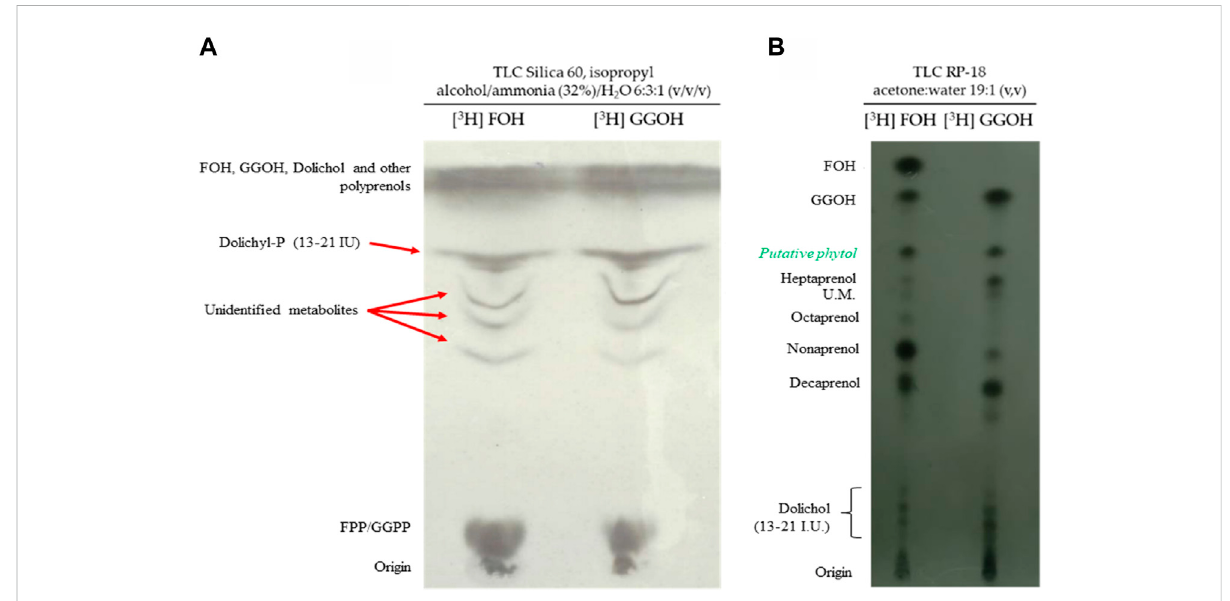
FIGURE 3 The metabolization of isoprenoid alcohols. (A) Autoradiography of a TLC analysis (TLC plates silica gel 60 developed with isopropyl alcohol/ ammonia